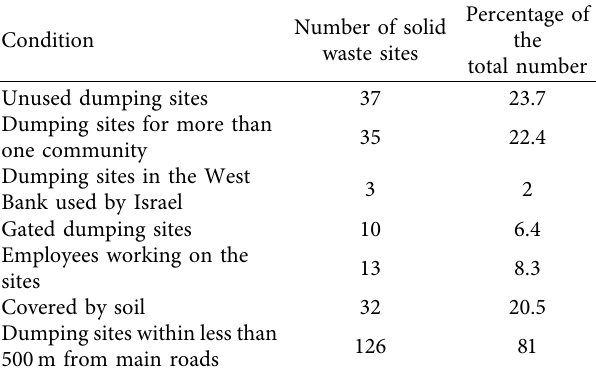
Table 1: Some facts about dumping sites in the West Bank